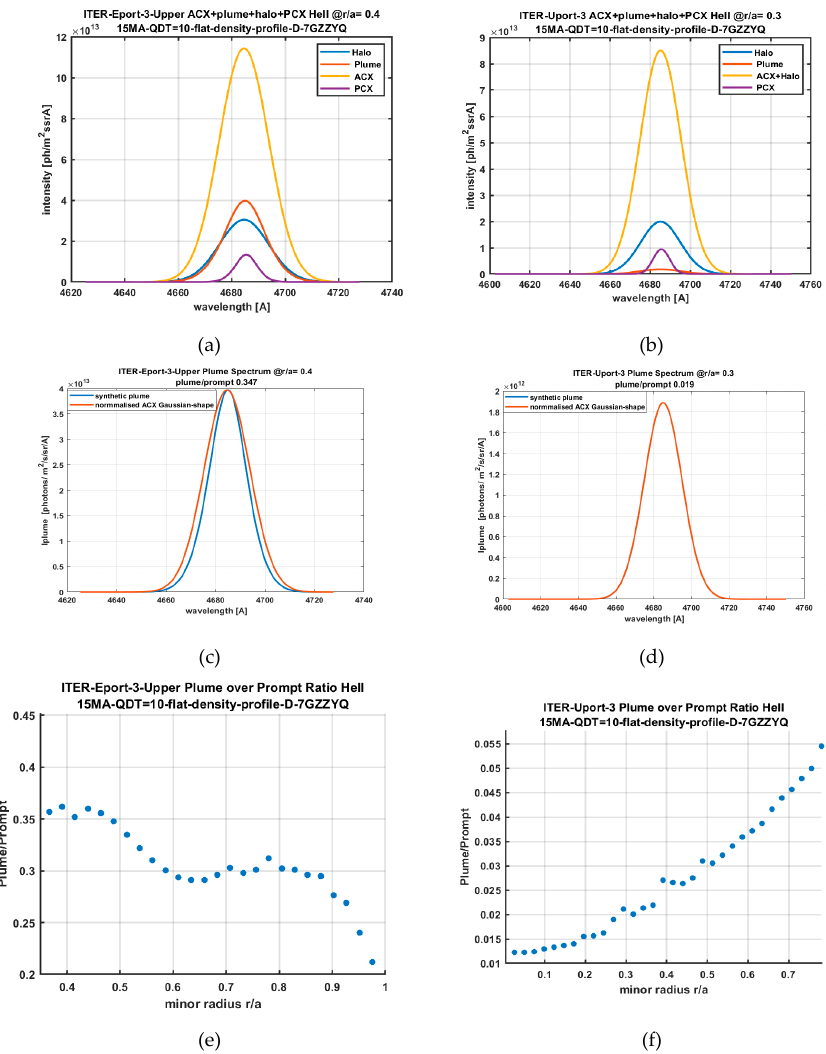
Figure 19. ( a ) Synthetic Non-Gaussian HeII plume spectrum for ‘worst plume case’ using E-port-Upper with lines of sight almost parallel to magnetic field lines. Halo/prompt 29%, plume/prompt 35%; ( b ) Synthetic HeII plume spectrum for ‘minimum plume case’ using U-port-3 with lines of sight 60 o to magnetic field lines. Halo fraction 23%, plume/prompt 1.9%; ( c ) Synthetic non-Gaussian HeII plume spectrum and comparison to normalized Gaussian shape of prompt ACX spectrum for ‘worst plume case’ using E-port-Lower with lines of sight almost parallel to magnetic field lines. Plume/prompt 35% at r = 0.4; ( d ) Synthetic near Gaussian HeII plume spectrum and comparison to normalized Gaussian shape of prompt ACX spectrum for ‘minimum plume case’ using Uport-3 with lines of sight 60 o to magnetic field lines. Plume/prompt 2% at r = 0.3; (e) Plume-over-Prompt ratio for ‘worst plume case’ using E-port-Upper with lines of sight almost parallel to magnetic field lines. ( f )Plume-over-Prompt ratio for ‘minimum plume case’ using Uport-3 with lines of sight about 60 o to magnetic field lines.